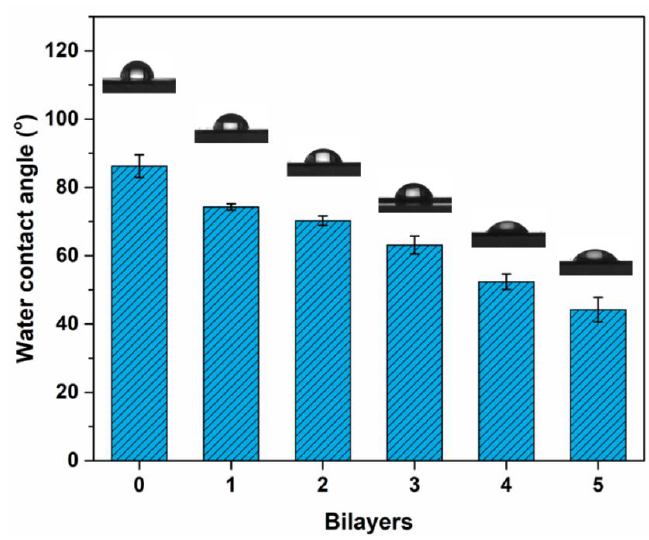
Figure 8. Water contact angles of the PSf membranes with different bilayer numbers.